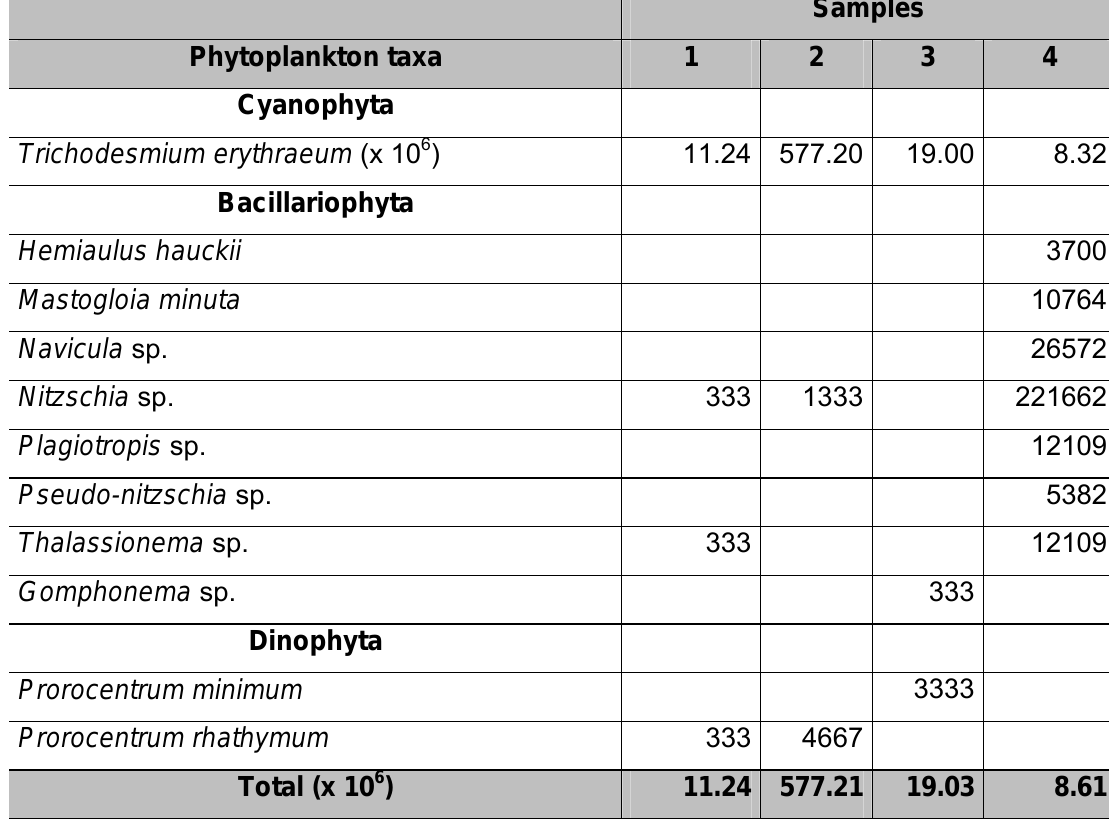
Table 1. List of phytoplankton taxa and their abundances in the four samples analyzed from the Camamu-Almada